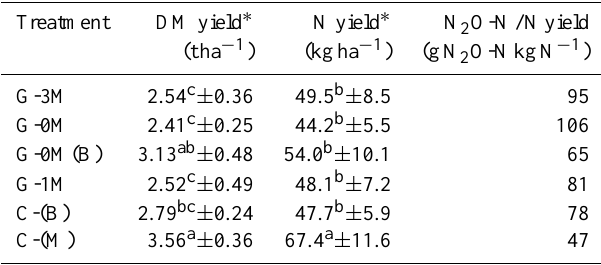
∗ Data from R. Frøseth,